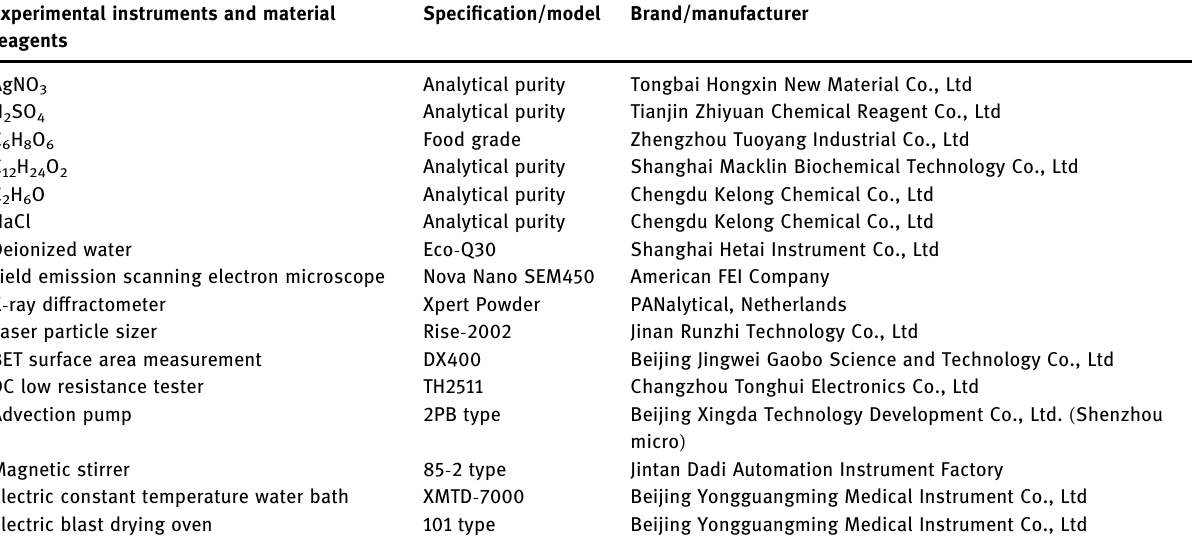
Table 1: The experiment equipment and reagents Experimental instruments and material